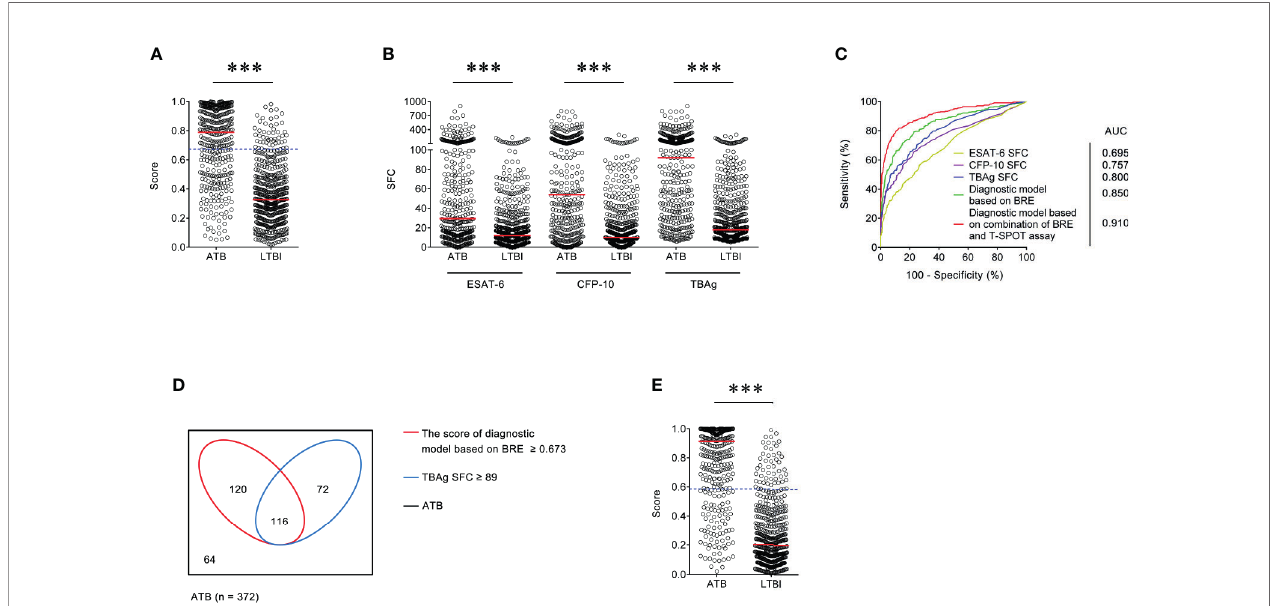
FIGURE 2 | Validation of diagnostic model based on combination of BRE and T-SPOT in Caidian cohort. (A) Scatter plots showing the score of diagnostic model based on BRE in ATB patients (n = 372) and LTBI individuals (n = 511) in Caidian cohort. Horizontal lines indicate the median. *** P < 0.001 (Mann-Whitney U test). Blue dotted lines indicate the cutoff value in distinguishing these two groups. (B) Scatter plots showing ESAT-6 SFC, CFP-10 SFC, and TBAg SFC in ATB patients (n = 372) and LTBI individuals (n = 511) in Caidian cohort. Horizontal lines indicate the median. *** P < 0.001 (Mann-Whitney U test). (C) ROC analysis showing the performance of ESAT-6 SFC, CFP-10 SFC, TBAg SFC, diagnostic model based on BRE, diagnostic based on combination of BRE and T-SPOT in distinguishing ATB from LTBI in Caidian cohort. (D) Venn diagrams showing the overlap of the diagnostic model based on BRE and TBAg SFC in ATB patients (n = 372) in Caidian cohort. (E) Scatter plots showing the score of diagnostic model based on combination of BRE and T-SPOT in ATB patients (n = 372) and LTBI individuals (n = 511) in Caidian cohort. Horizontal lines indicate the median. *** P < 0.001 (Mann-Whitney U test). Blue dotted lines indicate the cutoff values in distinguishing these two groups. ATB, active tuberculosis; LTBI, latent tuberculosis infection; ESAT-6, early secreted antigenic target 6; CFP-10, culture fi ltrate protein 10; TBAg, tuberculosis- speci fi c antigens; SFC, spot-forming cells; AUC, area under the curve; BRE, blood routine examination.